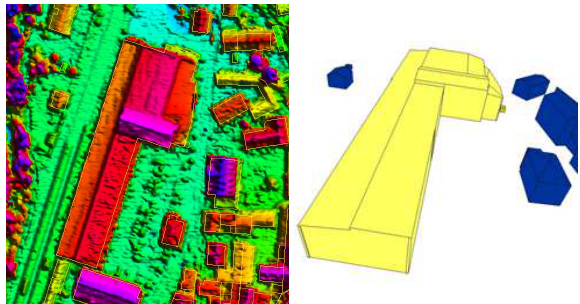
Figure 10. Detailed calculation of the roof structure with up-to- date DSM from oriented aerial photographs from the Bavarian